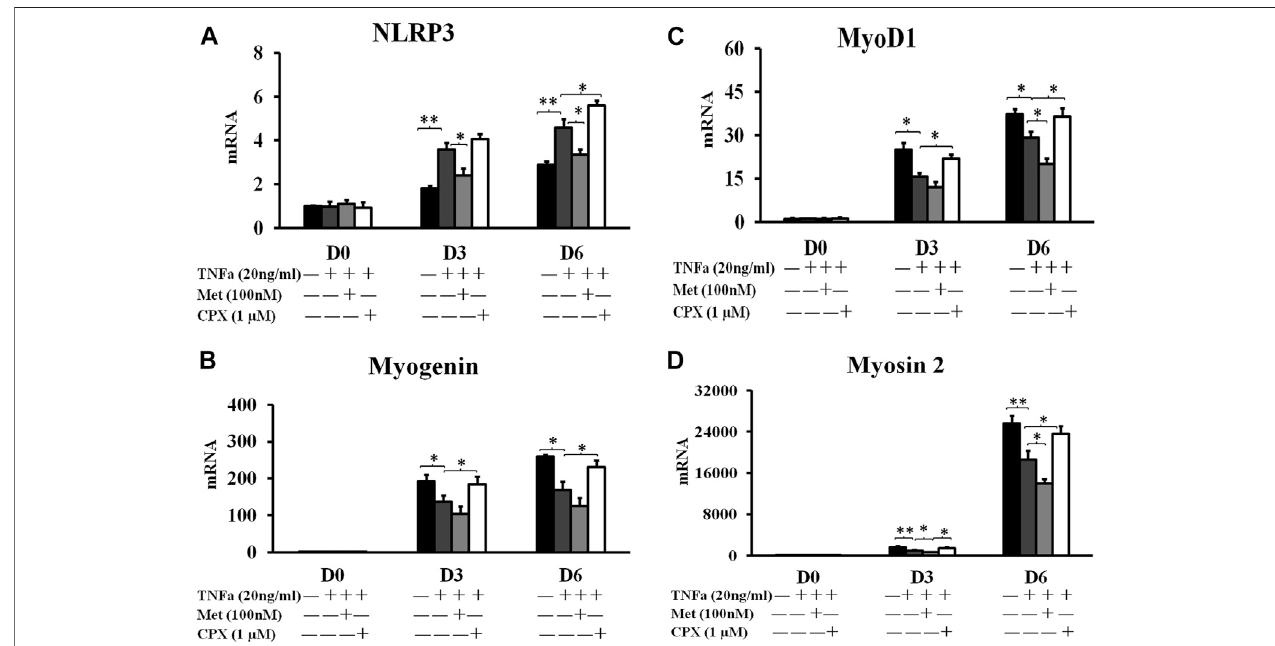
FIGURE 4 | The mRNA expression of in fl ammasome NLRP3 protein and myogenesis markers. C2C12 cells were incubated in the presence of TNFa (20 ng/ml), TNFa + Met (100 nM) or TNFa + CPX (1 µM) for 12 h at D0, D3, or D6. The mRNA expressions were assessed by real time RT-PCR. * p < 0.05, and ** p < 0.01 between two compared groups. Normalizing D0 ctrl (cid:2) 1 after compared with housekeeping gene PBGD. (A) : NLRP3 mRNA expression. (B) The mRNA expression of early myogenesis marker, MyoD1. (C) The mRNA expression of intermediate myogenesis marker, Myogenin. (D) The mRNA expression of late myogenesis marker, myosin 2. Ctrl, control; TNFa, murine Tumor Necrosis Factor-alpha; Met, methimepip; CPX, ciproxifan. D0, undifferentiated cells; D3, cells differentiated for 3 days; D6, cells differentiated for 6 days. NLRP3, Nucleotide-binding domain and leucine-rich repeat containing family, pyrin domain containing three.